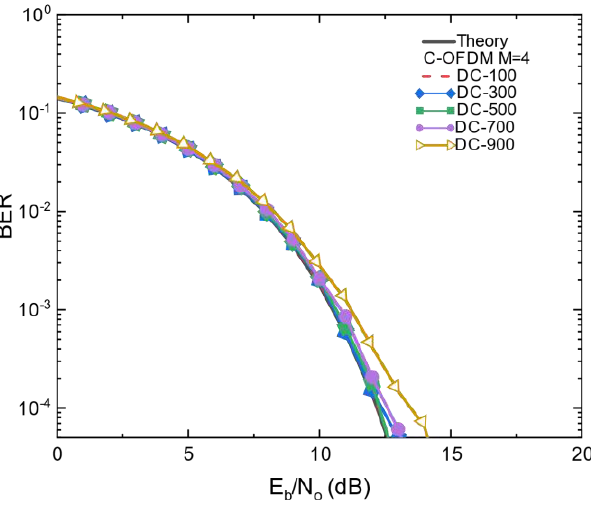
Figure 9. BER performance as a function of E b /N o for C-OFDM with 4-PAM and 200 AC.